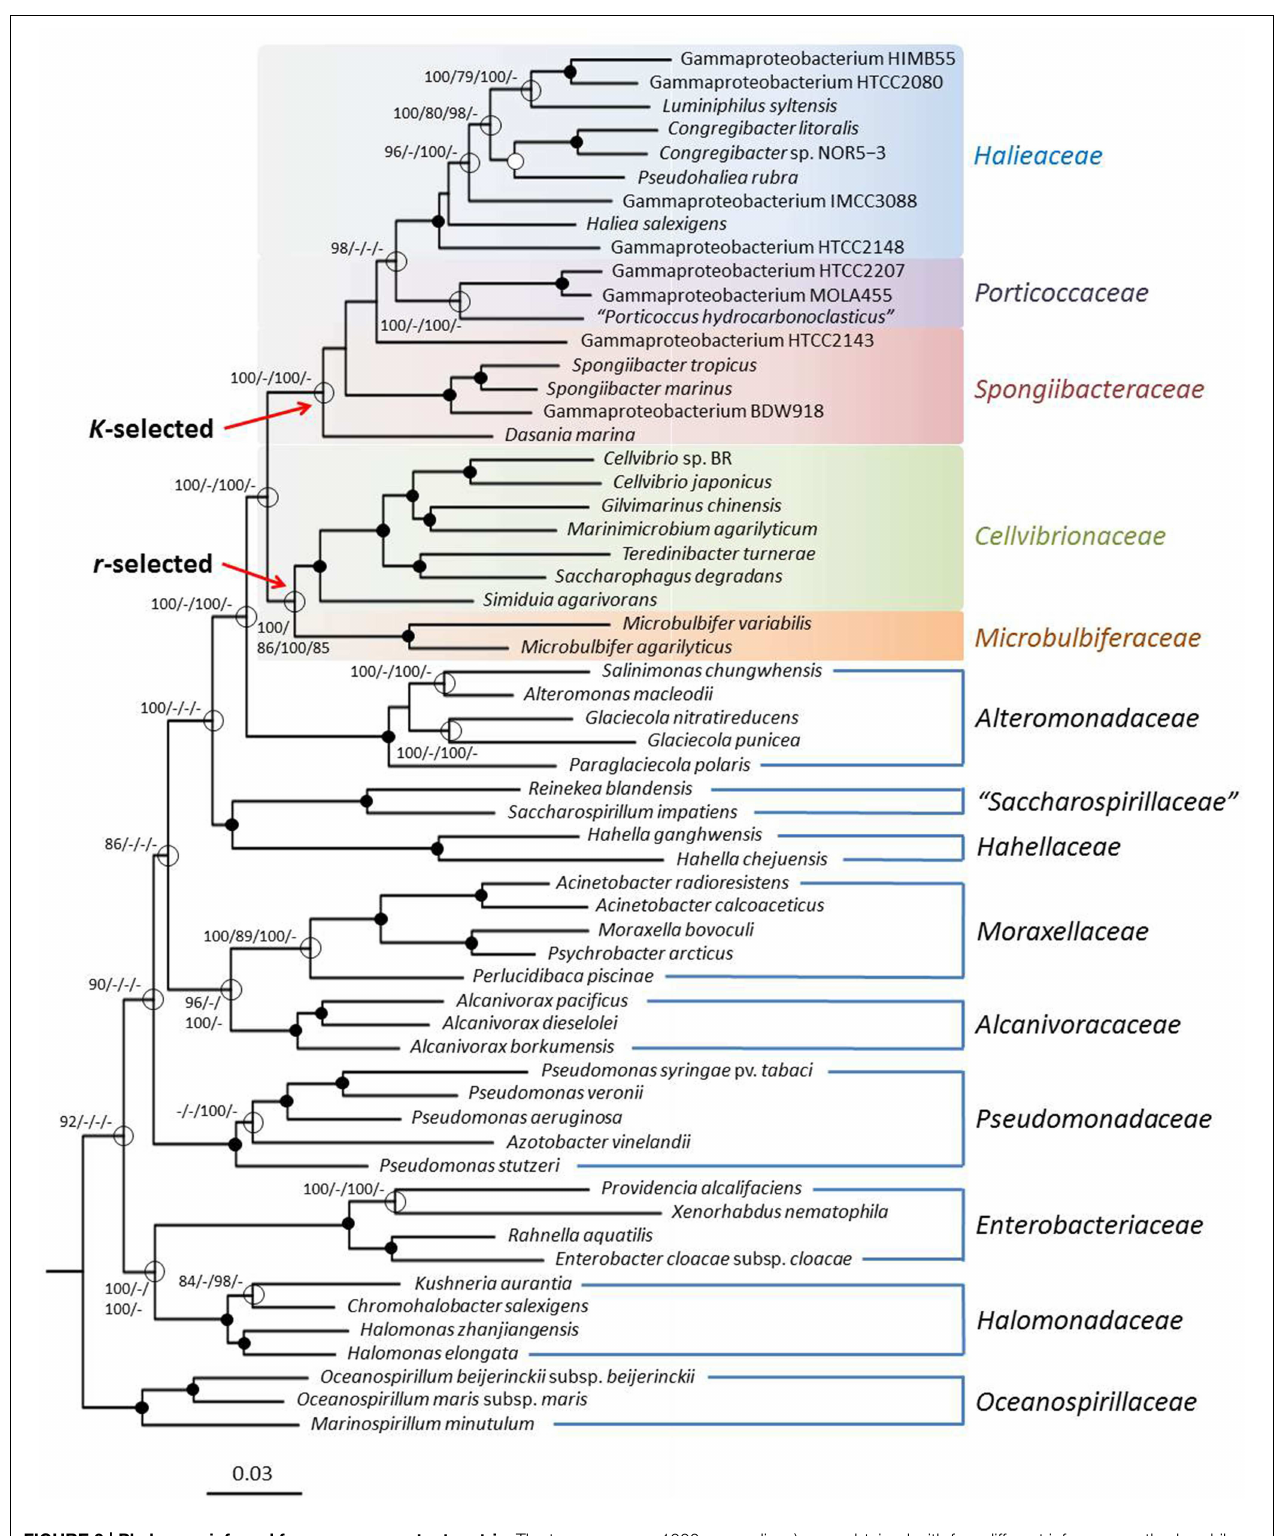
1000 resamplings) were obtained with four different inference methods, while white dots indicate that values of 95% or above were obtained with three reconstruction methods. Hollow circles indicate that bootstrap values of 75% (Continued)